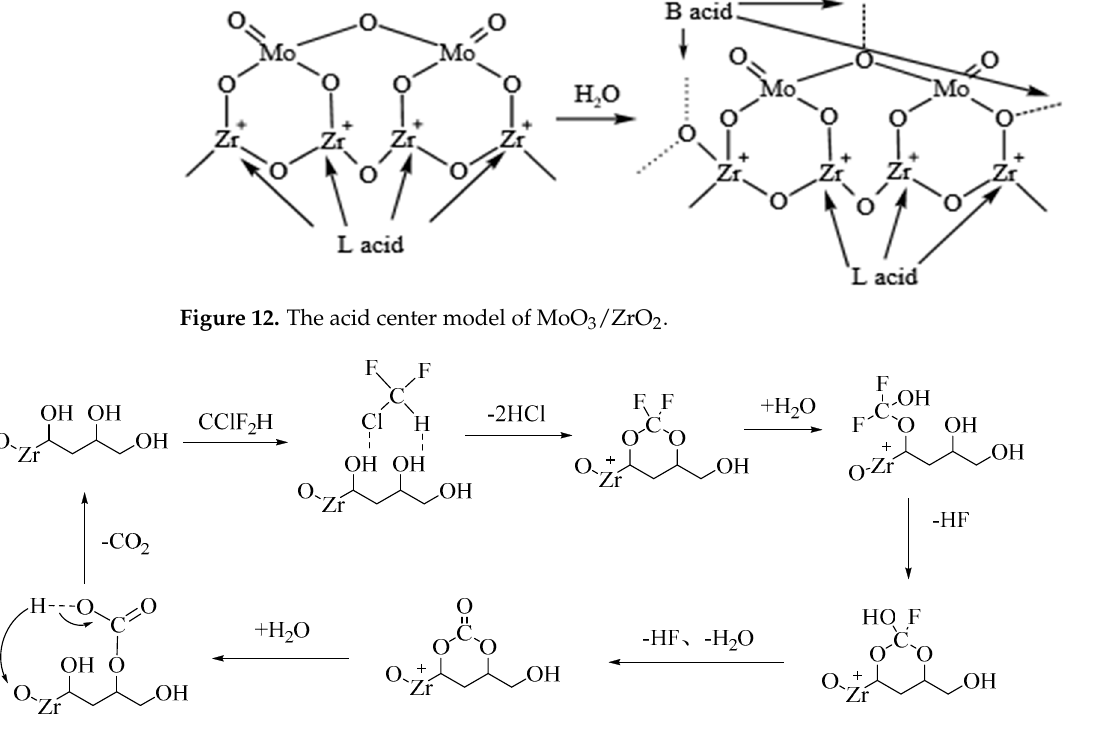
Figure 14. Schematic drawing of the synthesis catalytic hydrolysis of HCFC-22 by MgO/ZrO 2. 3. Experimental Section 3.1. Catalyst Preparation